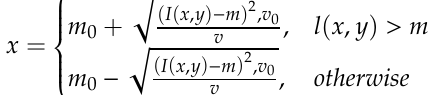
Figure 3. XFinger-Net architecture. In Figure 3, the depth of the attention gate increases from right to left. The last convolutional layer of the entire network is the sigmoid layer, which outputs the final probability map of 512 × 512 × 1. The layers and the corresponding output sizes in the network architecture are shown in Table 2. Table 2. Optimal results for two different load cases. Layer